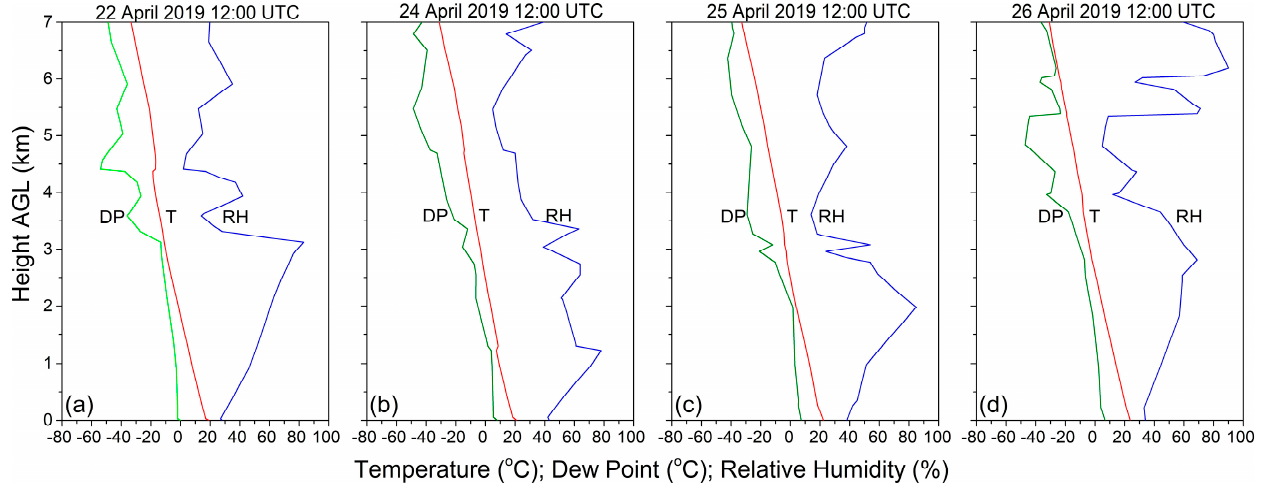
Figure 6. Meteorological radiosonde diagrams for the days of lidar measurements: ( a ) 22 April 2019, ( b ) 24 April 2019, ( c ) 25 April 2019, and ( d ) 26 April 2019; T—temperature; DP—dew point; RH—relative humidity.